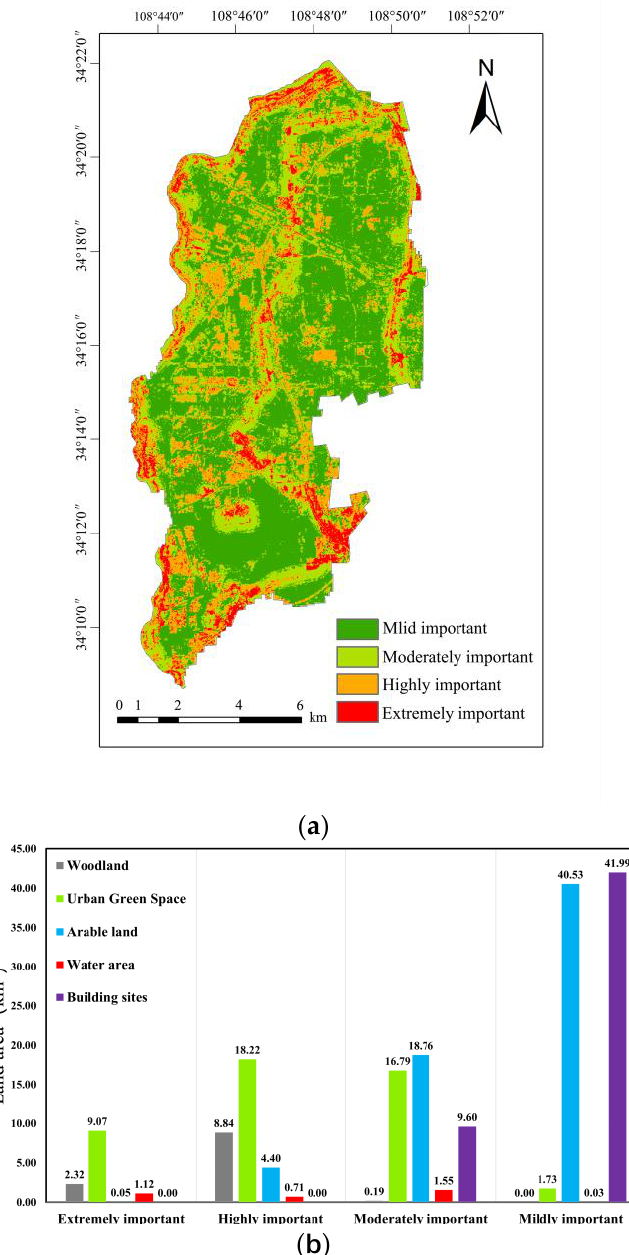
Figure 5. Ecosystem function evaluation. ( a ) Evaluation results of ecosystem function importance; ( b ) land analysis.